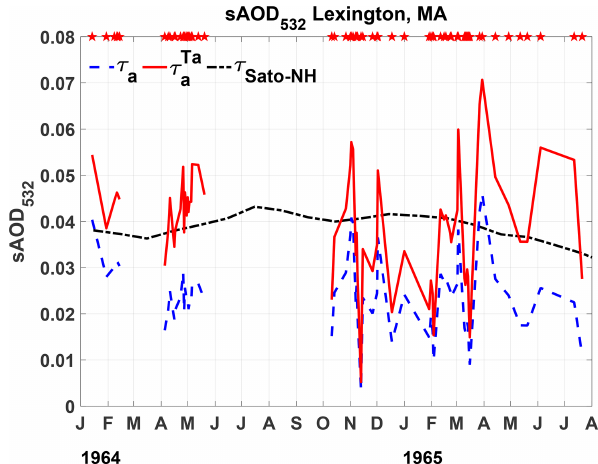
Figure 8. Time series of stratospheric AOD (sAOD 532 ) for Lexing- ton for τ a (532 ,z ) and τ T a a (532 ,z ) compared to that from the NASA Goddard Institute for Space Studies volcanic aerosol dataset (Sato et al.,